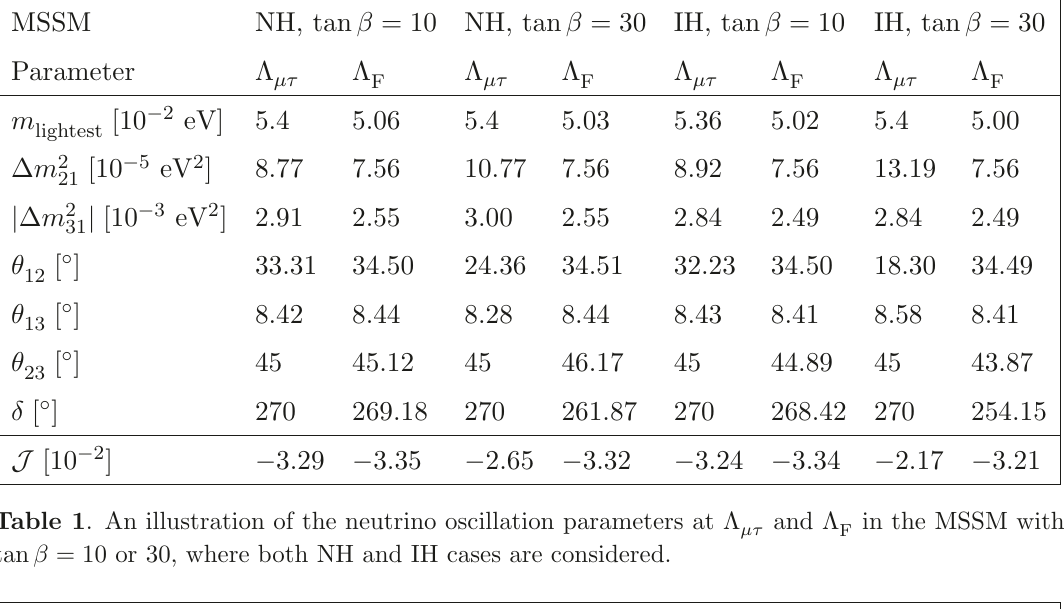
and Λ in the MSSM with µτ F